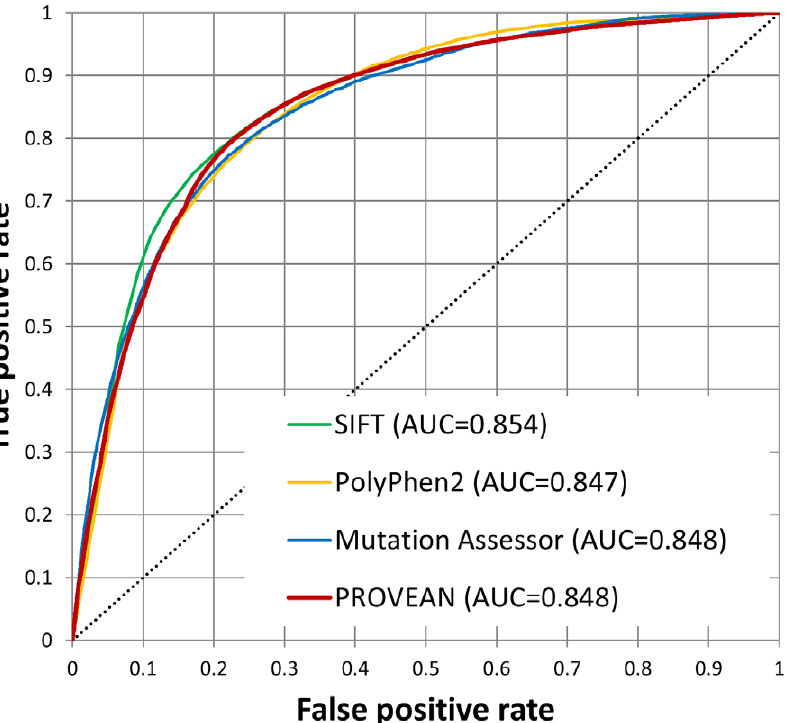
Figure 5. ROC curves of four different prediction tools for single amino acid substitutions found in human and non-human proteins. All tools show a similar predictive ability with the AUC value of , 0.85.